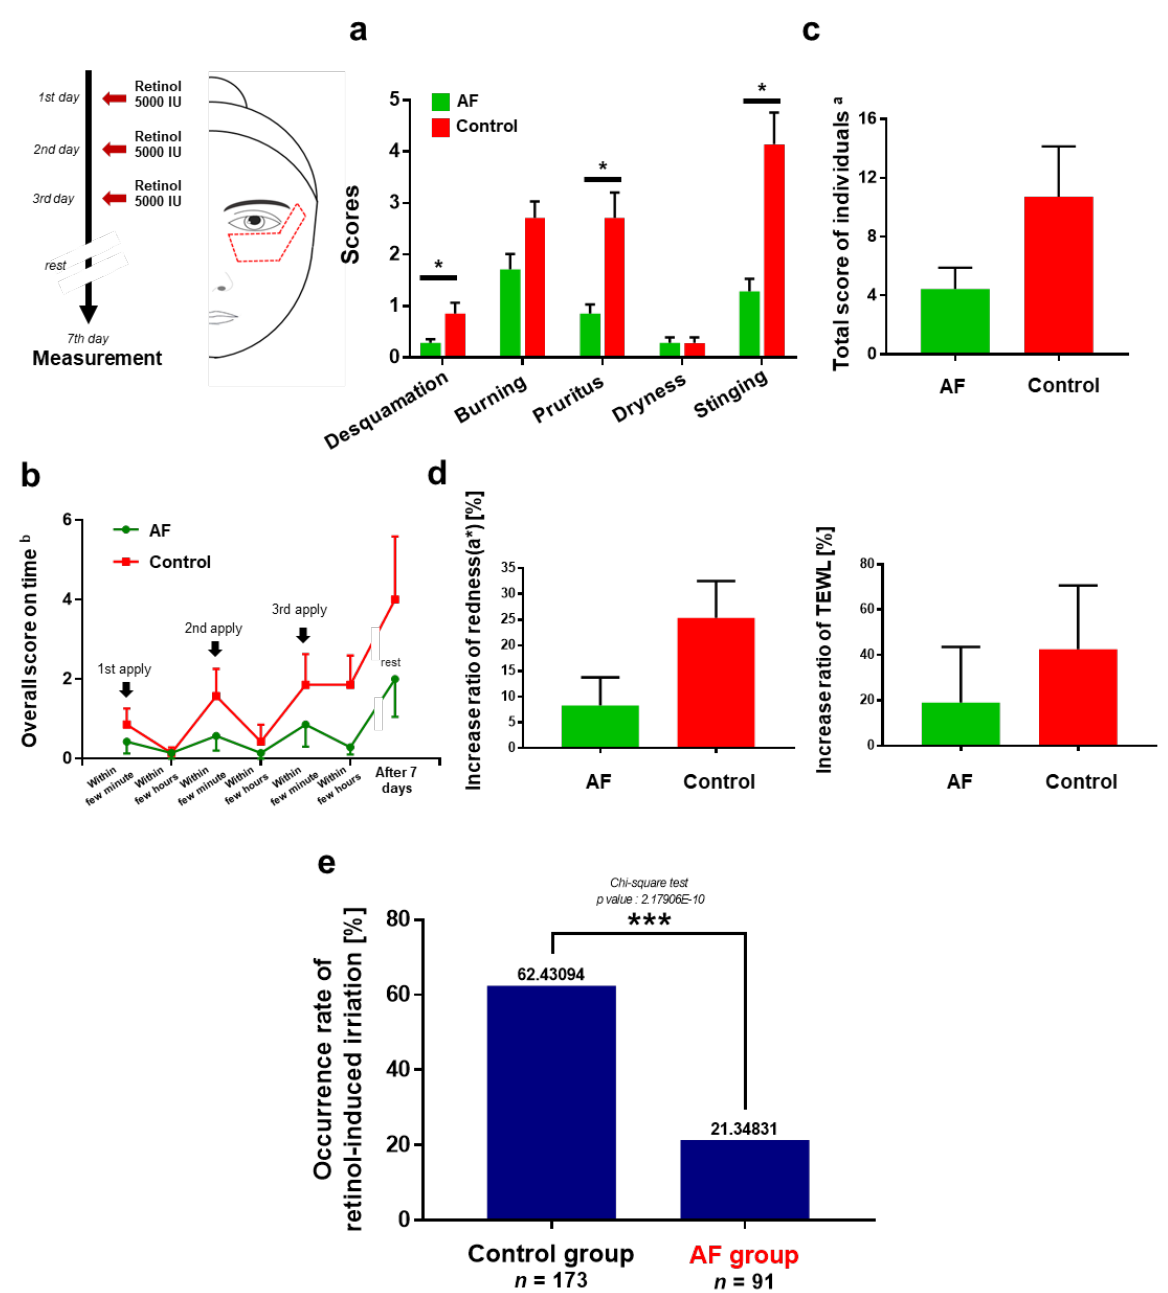
Figure 4. Schematic and plots depicting the anti-irritant efficacy of AF. Panel ( a – d ) indicate the results of the small pilot study ( n = 7). Left schematic diagram shows the test schedule and procedure and test area (red dotted) results of the face that was evaluated for the measurement of TEWL and skin redness. ( a ) Average of the irritation scores that the test subjects experienced during the test period. ( b ) Overall irritation score on each time point. Over irritation score b refers to the sum of scores of all types of irritation experienced by the individuals. ( c ) Total irritation score of the individuals. Total scores a for each type of irritation experienced by the individual during the test period were averaged. Overall scores b on each time point were summed. ( d ) Skin redness and transepidermal water loss (TEWL) measured by chromameter and tewameter. The increased ratios (%) for individuals were averaged. ( e ) Occurrence rate of retinol-induced irritation. Test human subjects were asked a dichotomous question, whether “retinol-based cream is irritant or not”, based on their own subjective criteria. A chi-square test was performed to investigate statistical significance. ( p -value: 2.17906E-10); * p -value < 0.05; *** p -value< 0.001; AF, Anti-irritant Formula against retinol-induced irritation; error bars are shown.